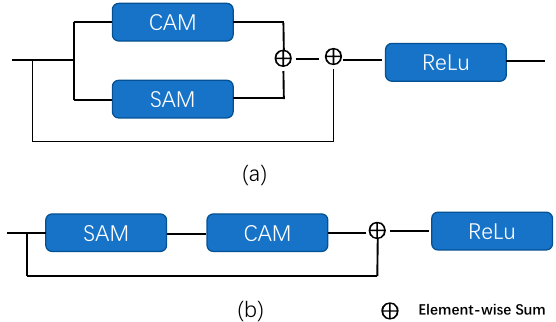
Figure 3. Overall structures of PCSAM with parallel and serial connections. ( a ) PCSAM connected in parallel; ( b ) PCSAM connected in serial.